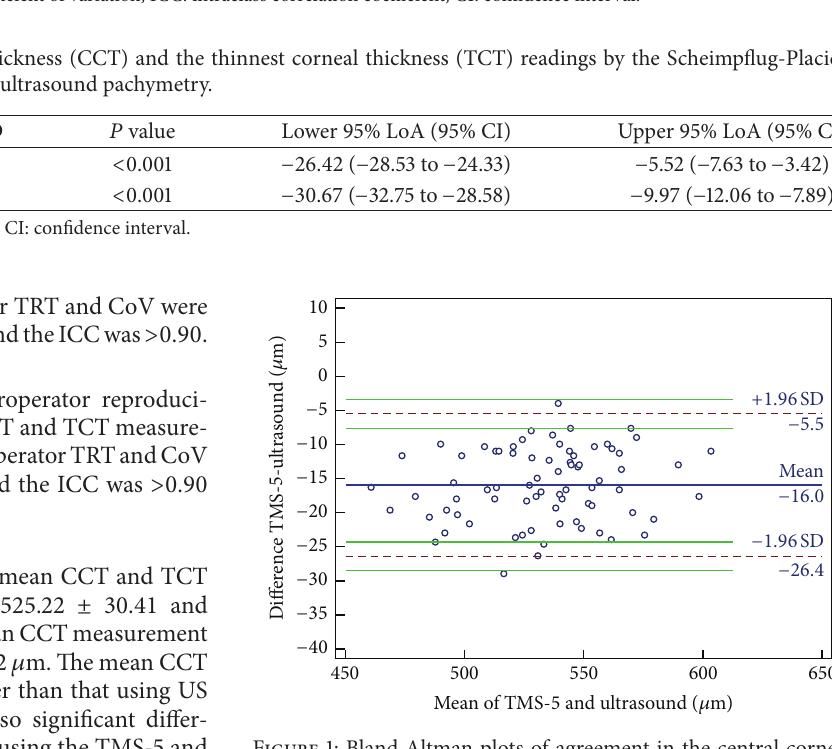
Figure 1: Bland-Altman plots of agreement in the central corneal thickness measurement between the Scheimpflug-Placido topo- graphic modeling system (TMS-5) and ultrasound pachymetry. The blue solid line indicates the mean difference (bias). The dashed lines represent the 95% limits of agreement. The upper and lower green solid lines represent the 95% limits of